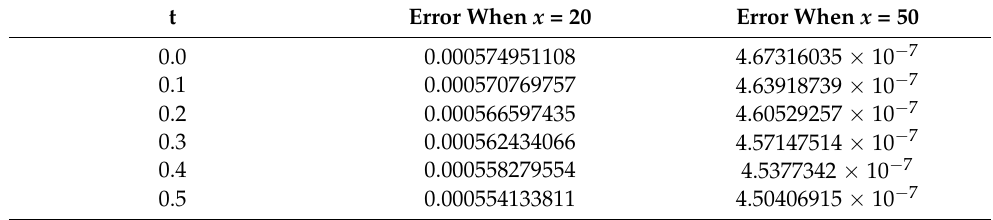
Table 3. Absolute error for Case 3 for x = 20, x =